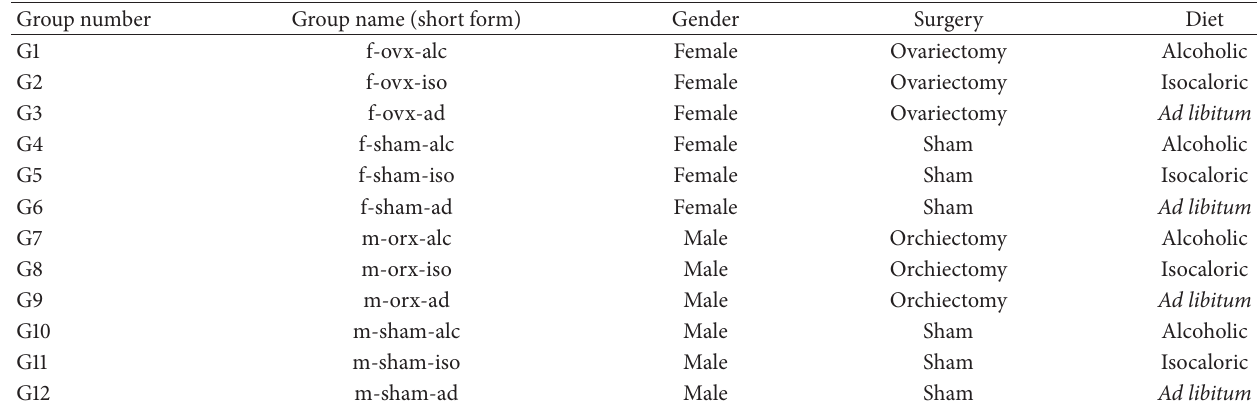
Table 1: Description of the experimental